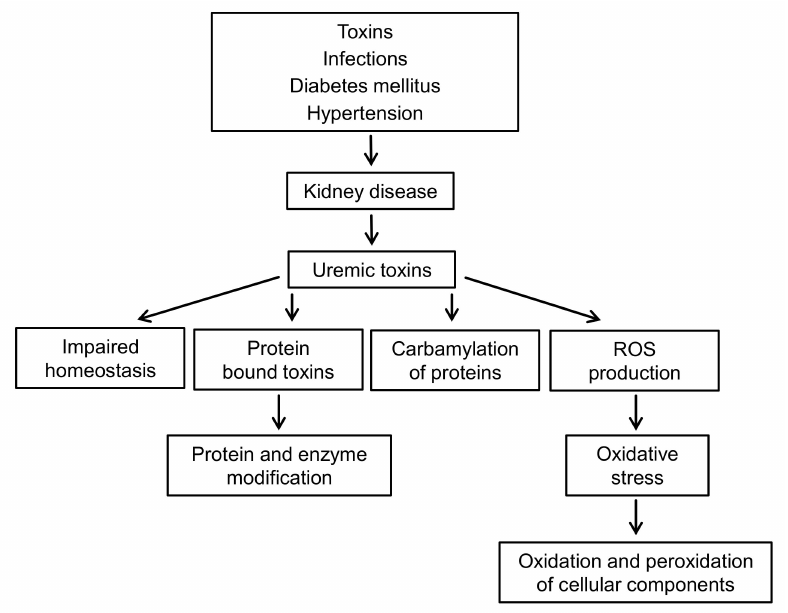
Figure 7. Cells and tissue damage in chronic kidney